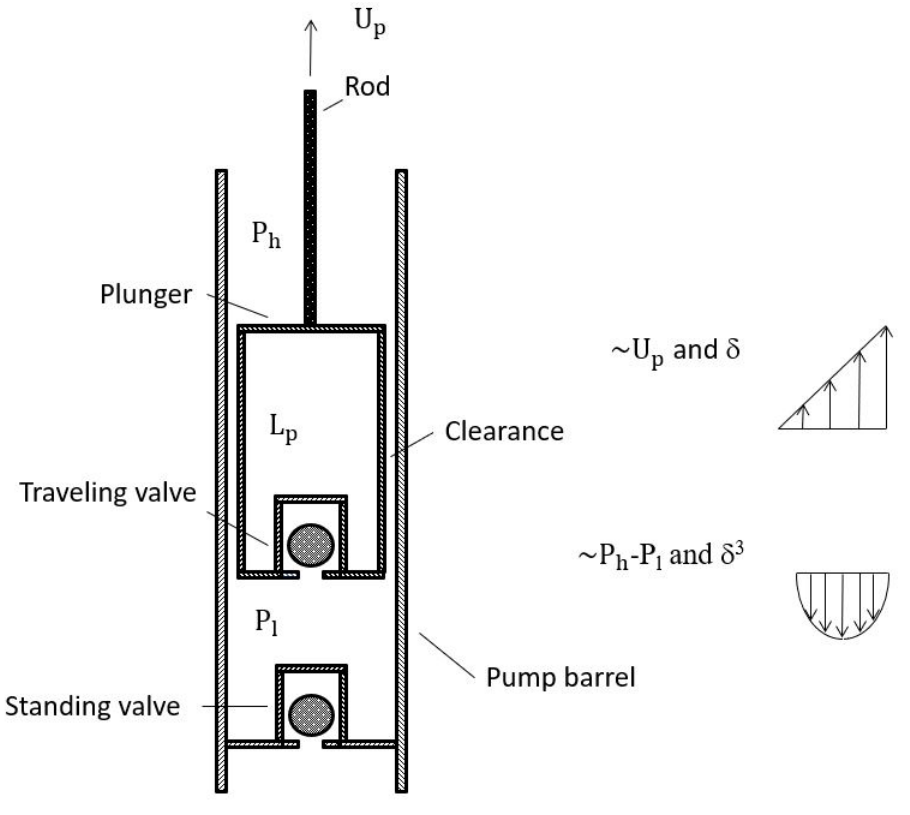
Figure 1. A typical sucker rod pump system Figure 1: A typical sucker rod pump system configuration.